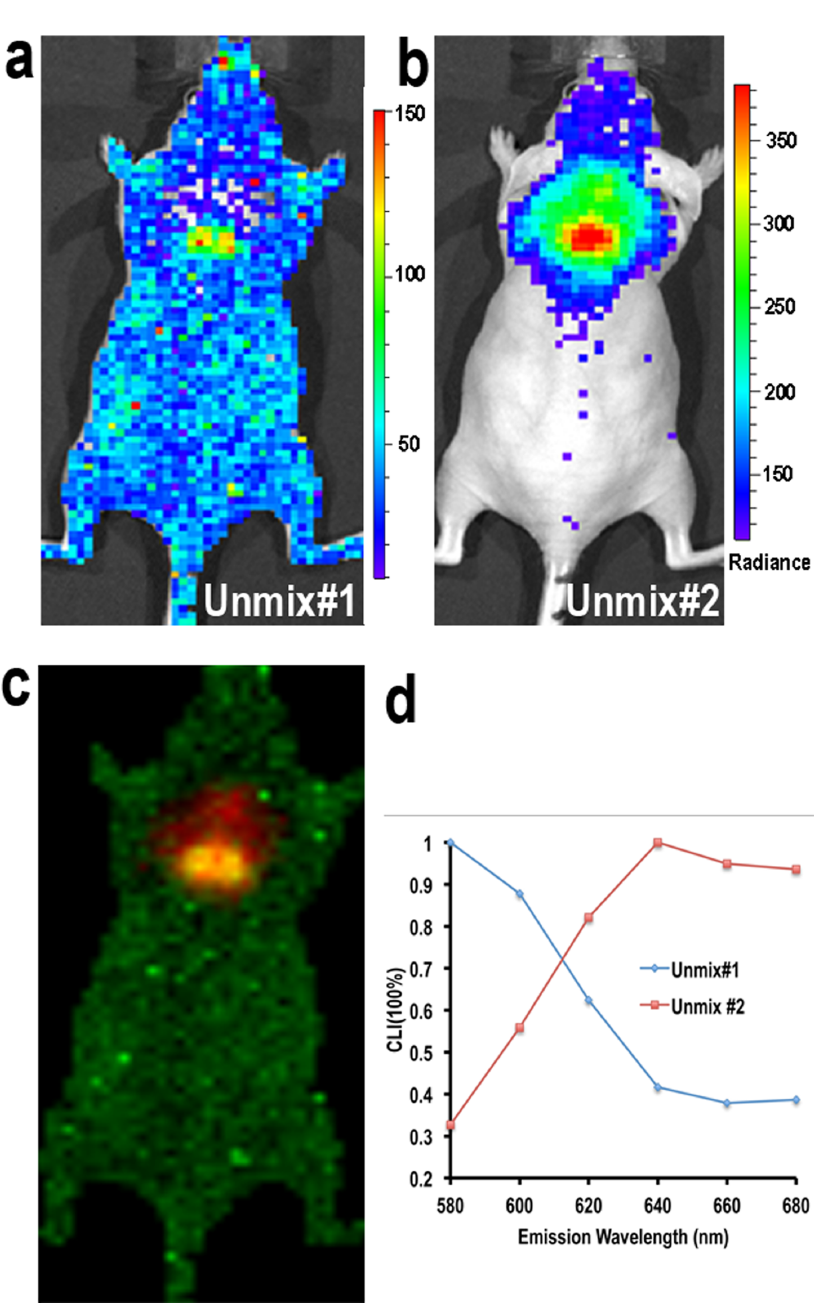
Figure 5. Spectral unmixing for unspecific CLI and BAT CLI. (a) Unmix # 1 showed that unspecific CLI signal from 18 F-FDG was distributed over the whole body (the unmixed spectrum for this image is shown in (d) (blue line)). (b) Unmix # 2 indicated that the majority of CLI at interscapular site was from BAT (the unmixed spectrum is shown in (d) (red line)). CLI peak was around 640 nm. (c) Merged image of Unmix # 1 and # 2. (d) The CLI spectra of Unmix # 1 and #